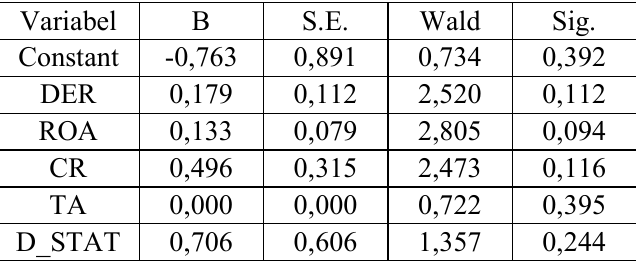
Sumber: Hasil Pengolahan Data SPSS